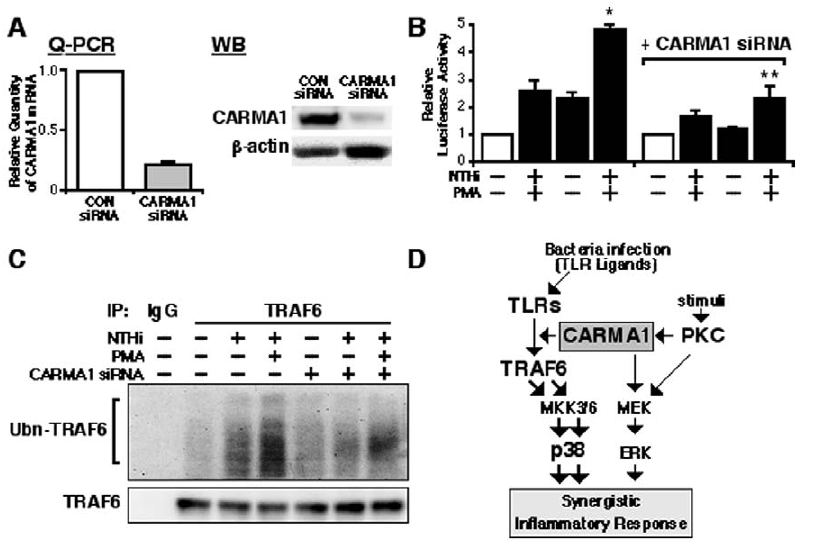
Figure 8. CARMA1 mediates TLR-dependent synergistic MUC5AC induction by NTHi and PMA via cross-talk with TRAF6. ( A ) CARMA1 knockdown by CARMA1-siRNA efficiently reduced the endogenous CARMA1 expression at both the mRNA and protein level, as assessed by Q-PCR and WB, respectively. ( B ) CARMA1-siRNA inhibited the synergistic induction of MUC5AC transcription by NTHi and PMA. Values are the means 6 S.D. (n=3). *p , 0.05 vs. NTHi alone; **p , 0.05 vs. control siRNA transfeced cells. ( C ) Synergistic enhancement of NTHi-induced TRAF6 polyubiquitination by PMA was attenuated by CARMA1 knockdown. ( D ) Schematic representation depicting how CARMA1 mediates the synergistic enhancement of MUC5AC expression in human epithelial cells. The data shown are representative of three independent experiments. CON, control; 2 , absence of; + , presence of; NTHi, nontypeable Haemophilus influenzae ; Ubn, ubiquitin; TLRs, toll-like receptors; TRAF6, TNF receptor associated factor 6; PKC, protein kinase